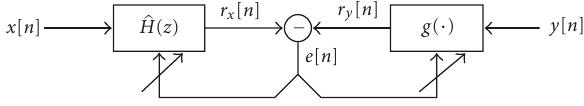
Figure 3: The used Wiener system identification